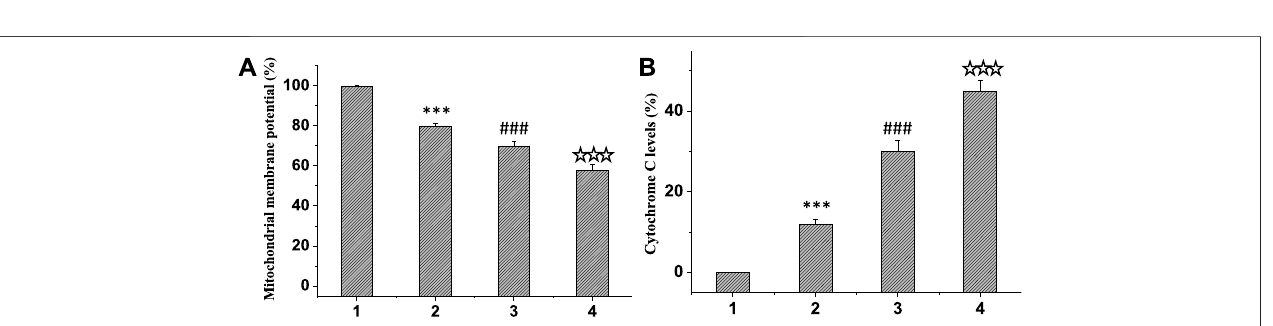
FIGURE6| Comparisonofmitochondrialmembranepotential (A) andcytochromeClevels (B) .1.PBS,2.curcumin,3.curcumin/CZL,4.curcumin/TPP-CZL.* p < 0.05,** p < 0.01,*** p < 0.001compared withPBSgroup;# p < 0.05,## p < 0.01,### p < 0.001compared withcurcumingroup; p < 0.05, p < 0.01, p < 0.001compared with CZL group.